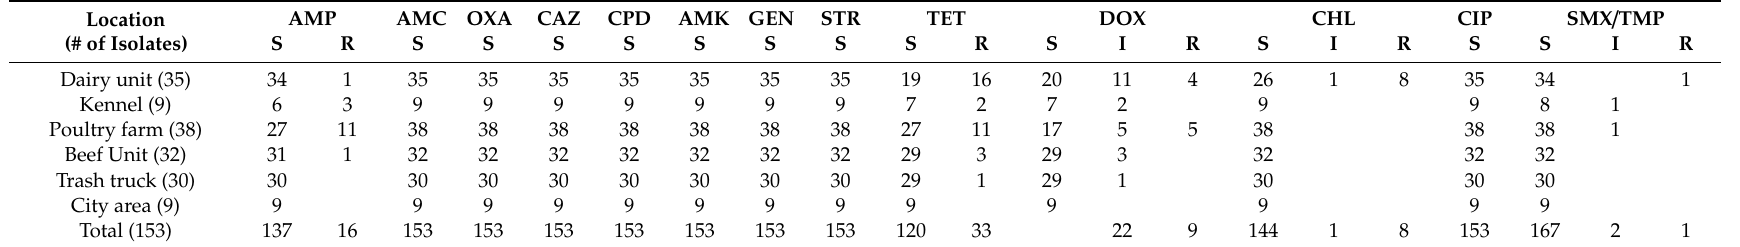
Table 3. Antibiotic susceptibility profile of CoNS isolated from